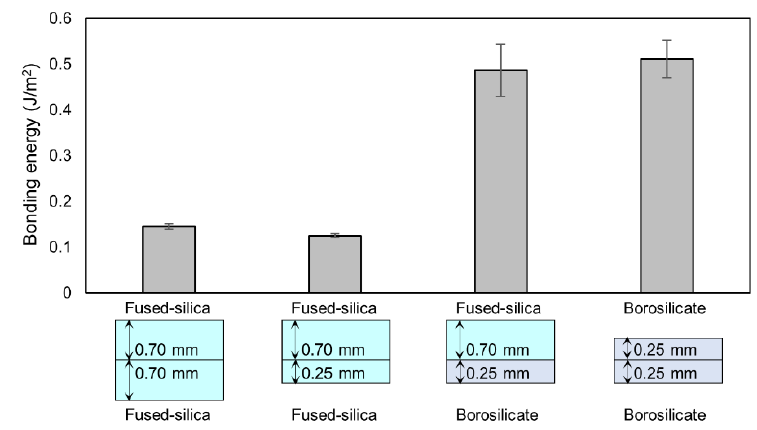
Figure 6. Bonding energies of fused-silica/fused-silica, fused-silica/borosilicate and borosilicate/borosilicate glass substrates at a heating temperature of 110 °C, measured by crack- opening test.